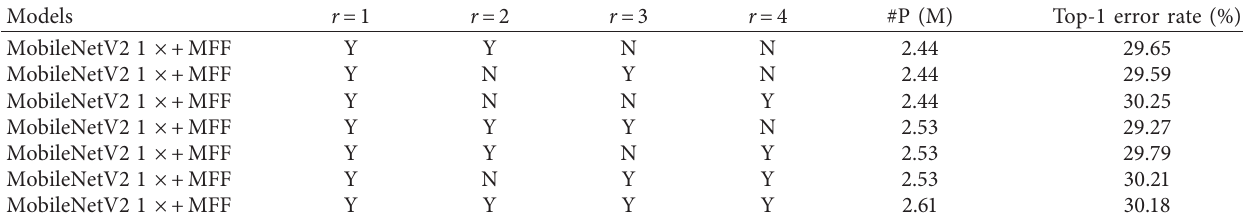
Table 6: Results for MobileNetV2 1 × with MFF for combinations of different atrous